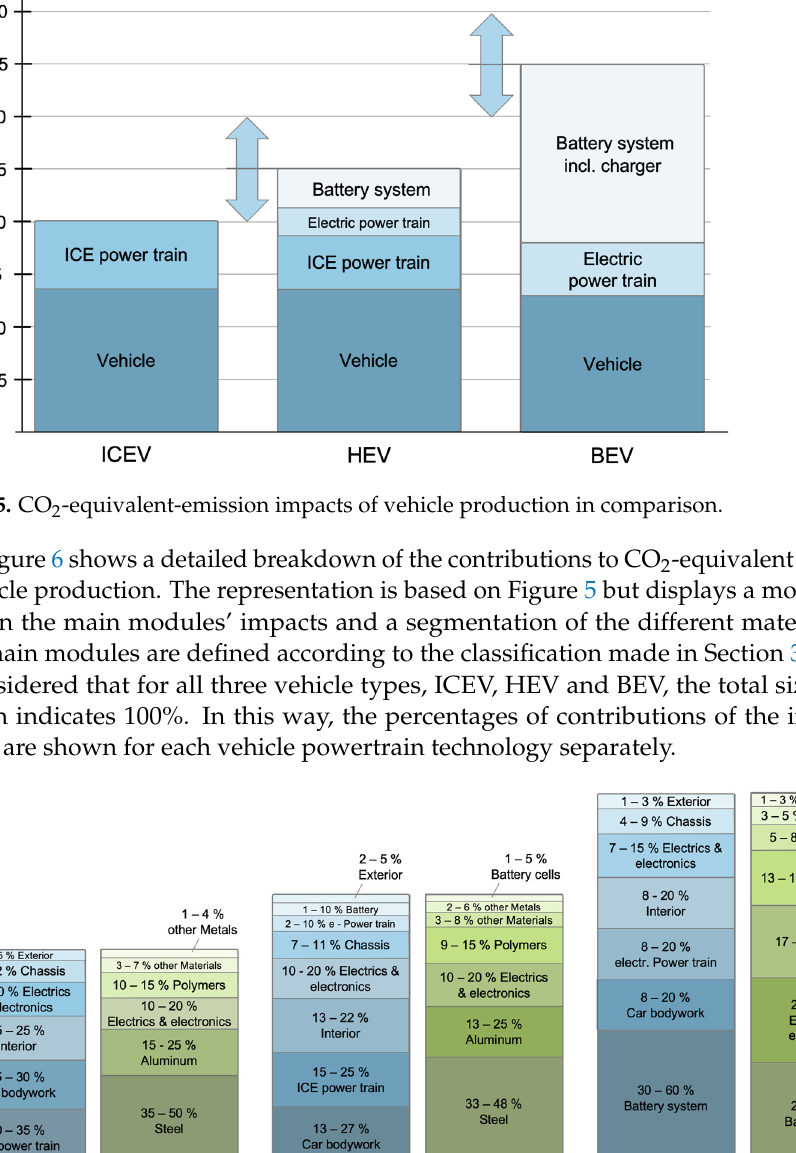
Figure 5. CO 2 -equivalent-emission impacts of vehicle production in comparison.